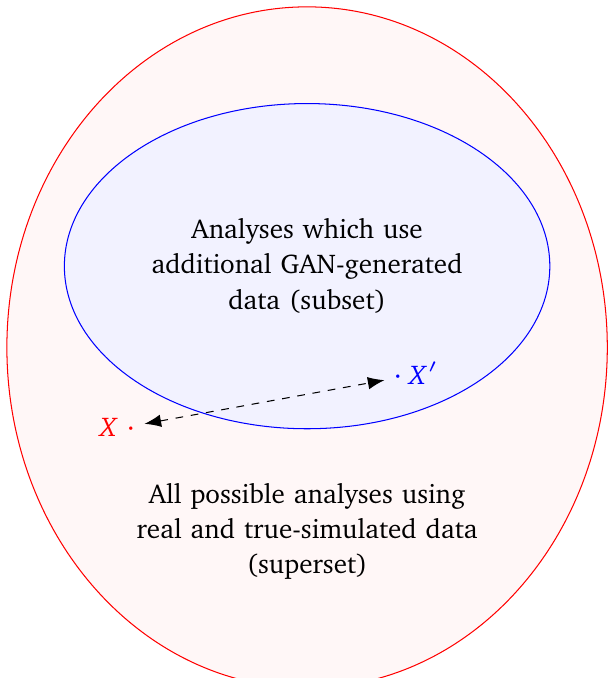
Figure 3: A Venn diagram illustrating the proof of Statement 1 discussion in Sec- tion 4.2